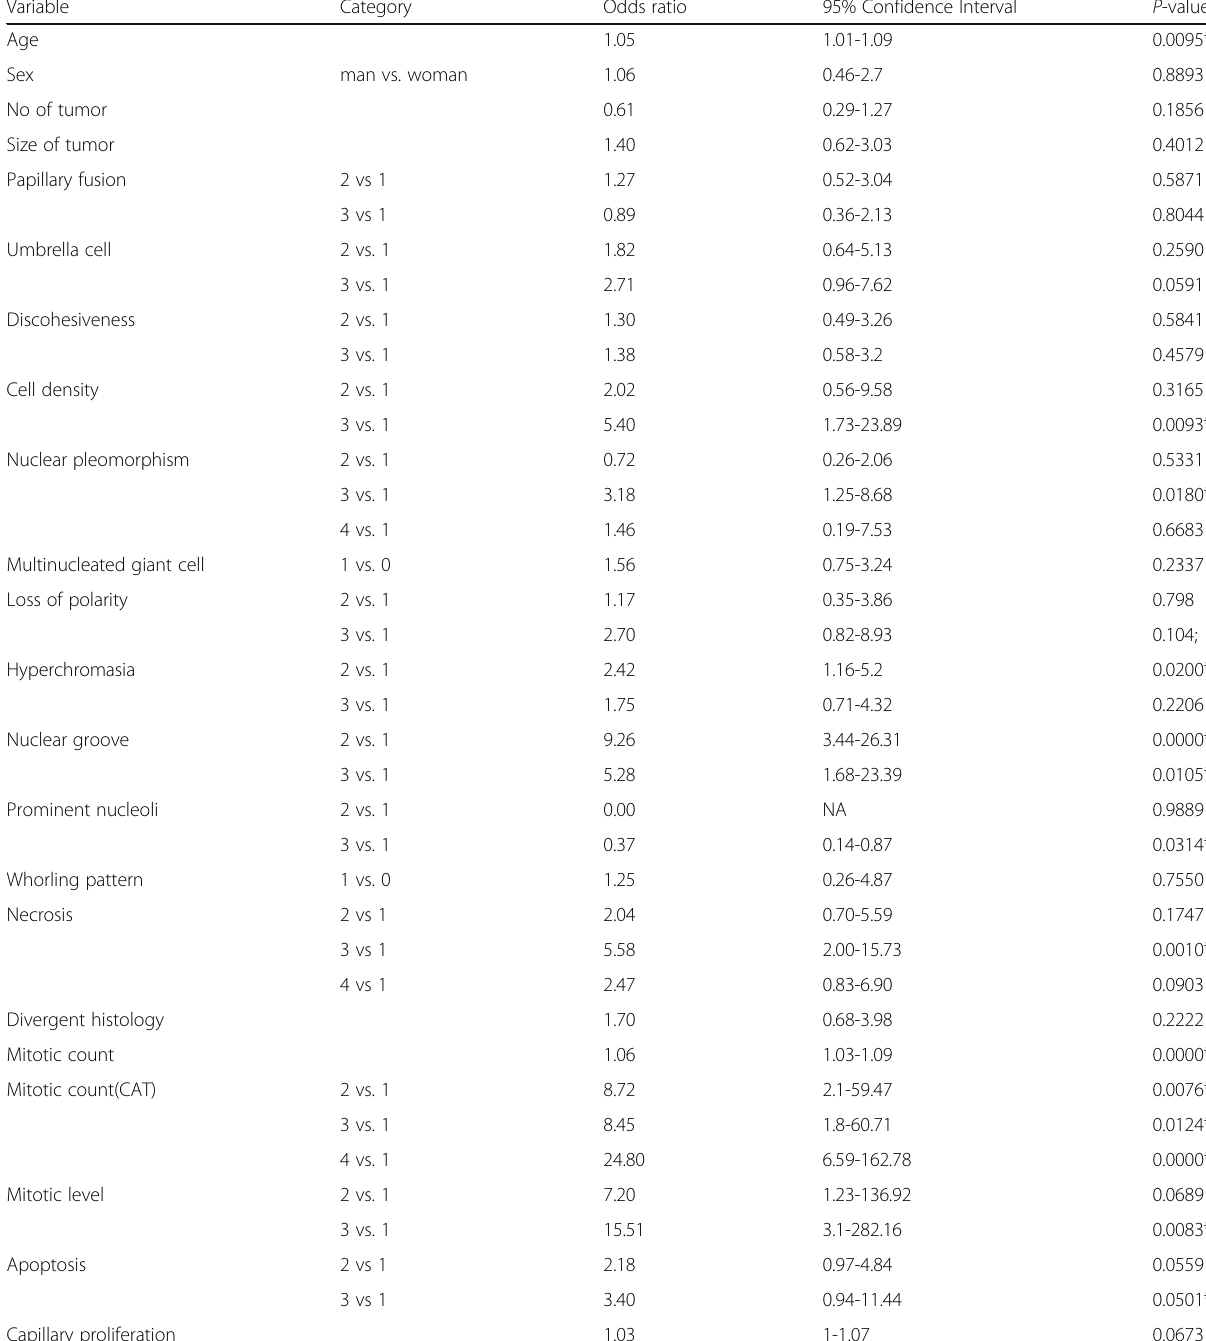
Table 4 Univariate analysis of factors associated with progression of PUC- Ta Variable